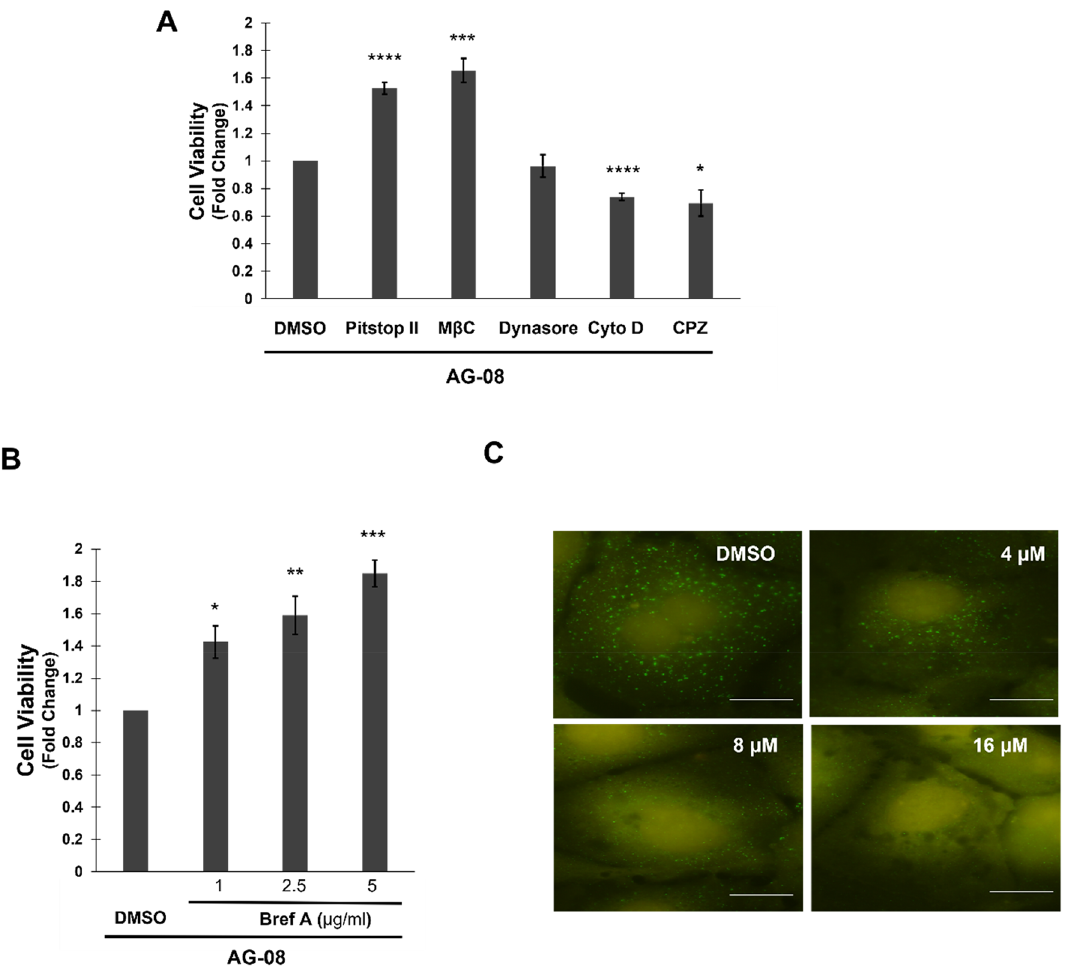
Figure 2. AG-08 is related with endosomal pathway. ( A ) After pre-treatment with 20 µM pitstop II, 0.5 mM methyl-β-cyclodextrin (MβC), 80 µM dynasore, 20 µM cytochalasin d (Cyto D) or 20 µM chlorpromazine (CPZ) for 1 h, HCC1937 cells were treated with 8 µM AG-08 for 24 h. Then cell viability was determined by using WST-1. Reported values were normalized on cells treated with only AG-08. Error bars are the standard deviations (n = 3). p-values were calculated with respect to AG-08 treated cells by two-tailed equal variance Student’s t-test (*p < 0.05, ***p < 0.001, ****p < 0.0001) ( B ) HCC1937 cells were treated with brefeldin A (Bref A) for 1 h and then treated with 8 µM AG-08 for 24 h. Error bars represent standard deviations (n = 3). p-values were calculated with respect to AG-08-treated cells (*p < 0.05, **p < 0.005, ***p < 0.001). ( C ) Following AG-08 treatment for 16 h, EEA1 proteins were stained using the anti-EEA1 antibody in HCC1937 cells (scale bar = 25